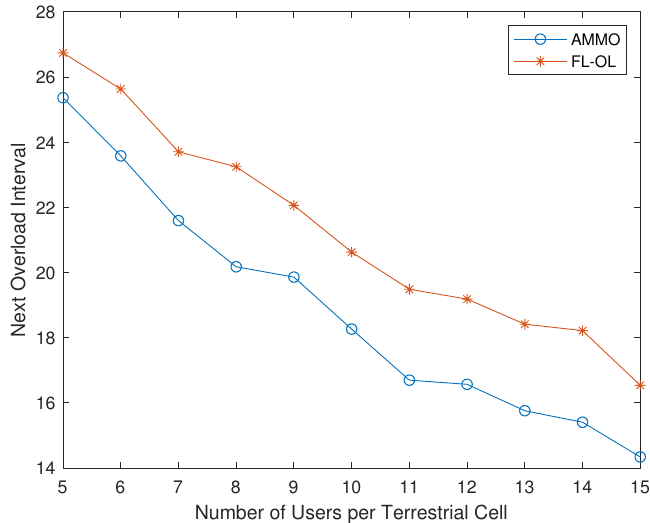
Figure 7. Next overload interval with different algorithms.